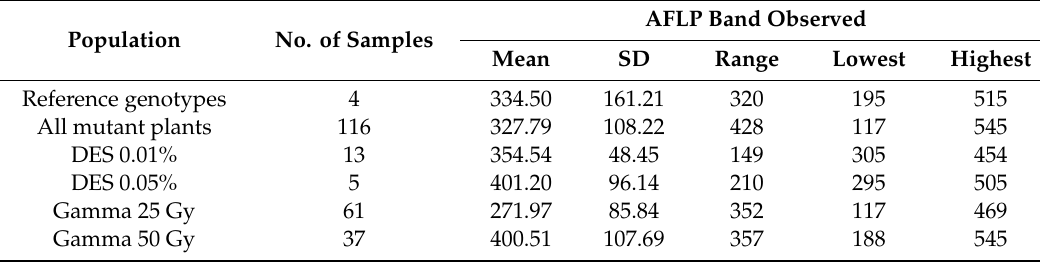
Figure 1. The frequency of occurrence of 1687 AFLP bands in 116 mutant plants and reference plants. Table 2. Mean performance and range of AFLP bands among mutant populations.